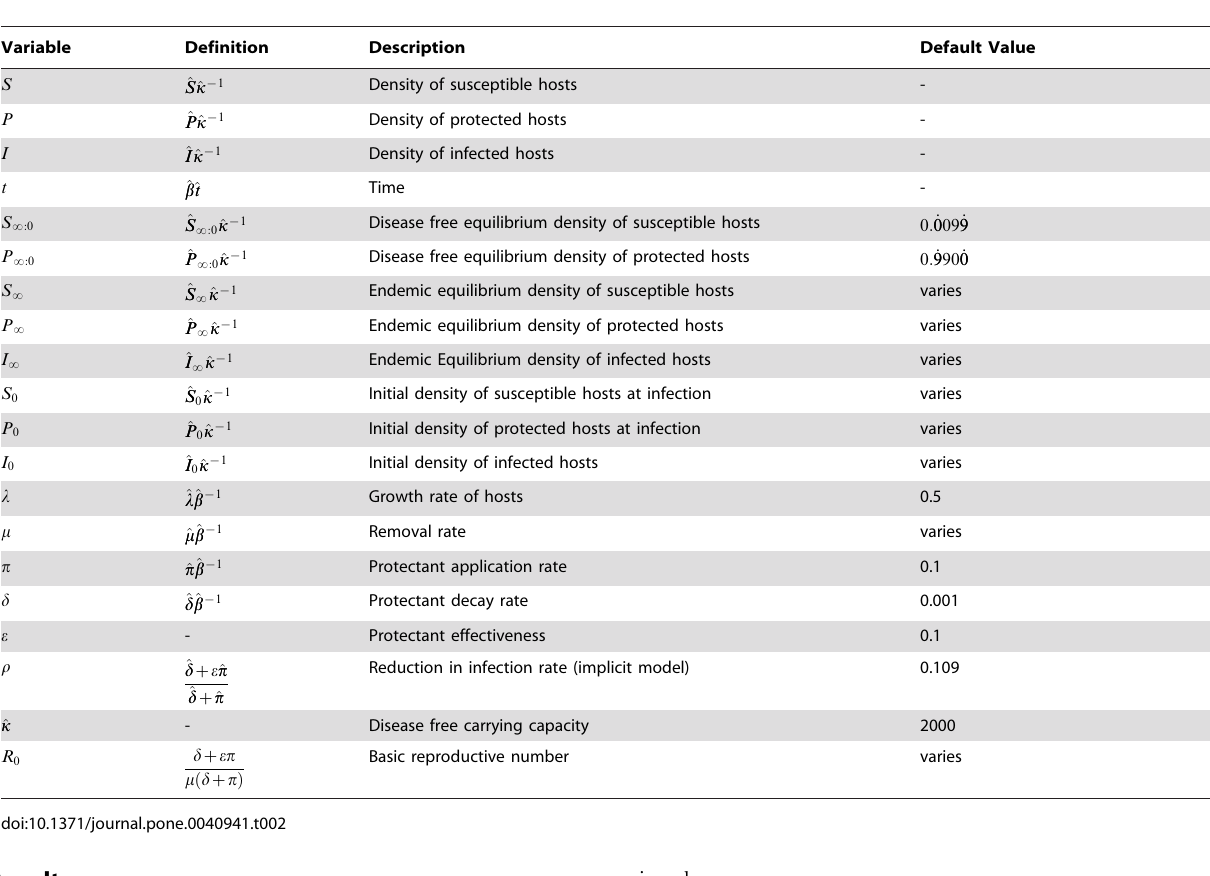
Table 2. Parameter Summary. Summary of dimensionless state variables, initial conditions, equilibria values and system parameters for both the implicit and explicit